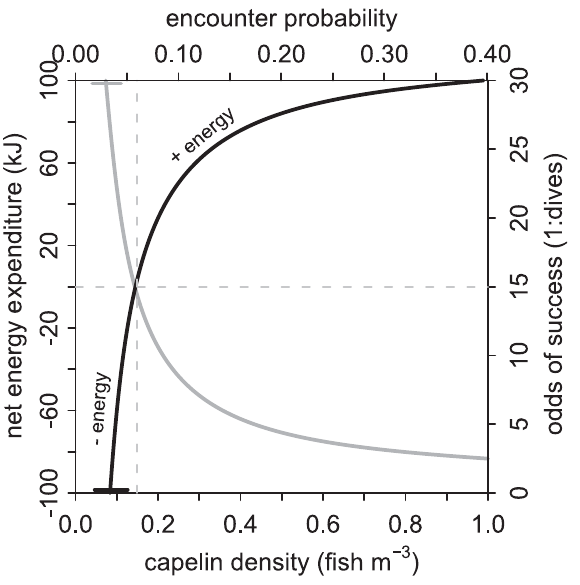
Figure 5. Modeled relationship between capelin density and net energy expenditure (black line). Net energy expenditure is a function of the number of dives required (grey line; energy cost) to encounter one capelin (energy gain). Results are based on 200 000 three-dimensional correlated random walk simulations.